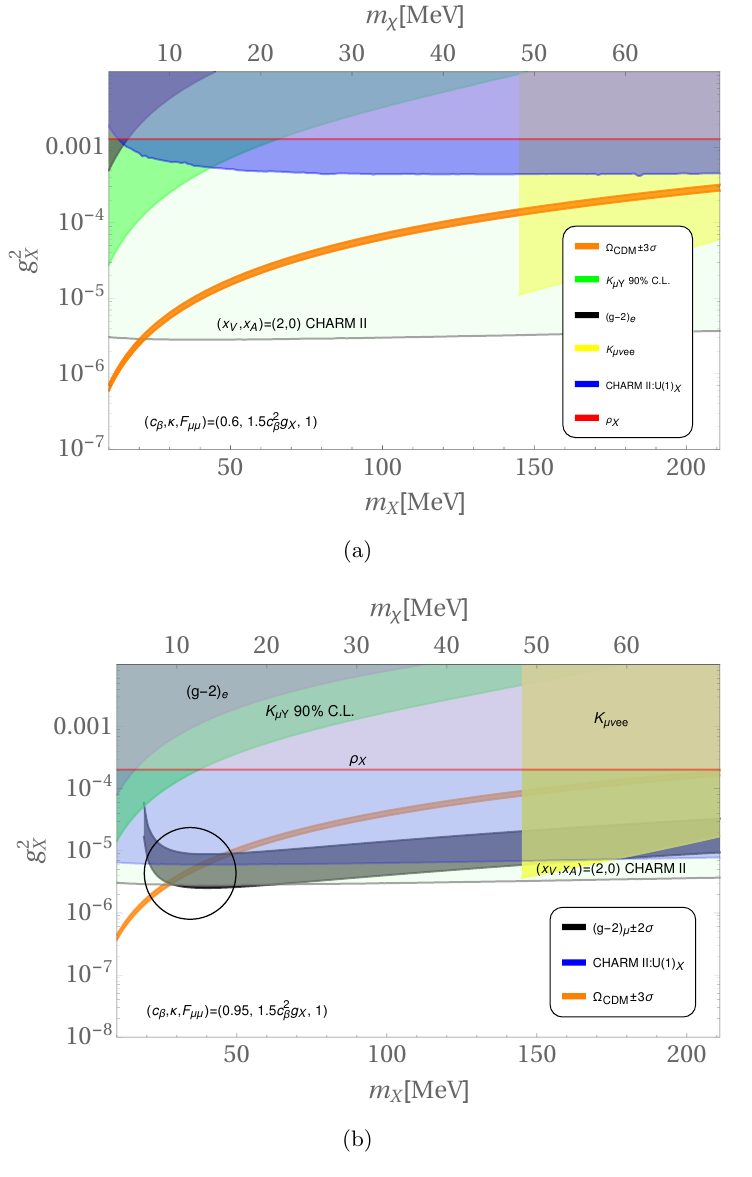
Figure 9 . The parameter space for (cid:20) = 3 c 2 g X . Notice, in (a), the excluded region for the dark (cid:12) 2 photon ( A 0 )(light-blue) is presented in comparison to the dark gauge boson ( Z 0 ) region (dark- blue). In (b), the di(cid:11)erence is reduced when c (cid:12) = 0 : 95 which, on the other hand, produces a possible solution both for the ( g (cid:0) 2) (cid:22) discrepancy and the (cid:10) CDM (circled region).